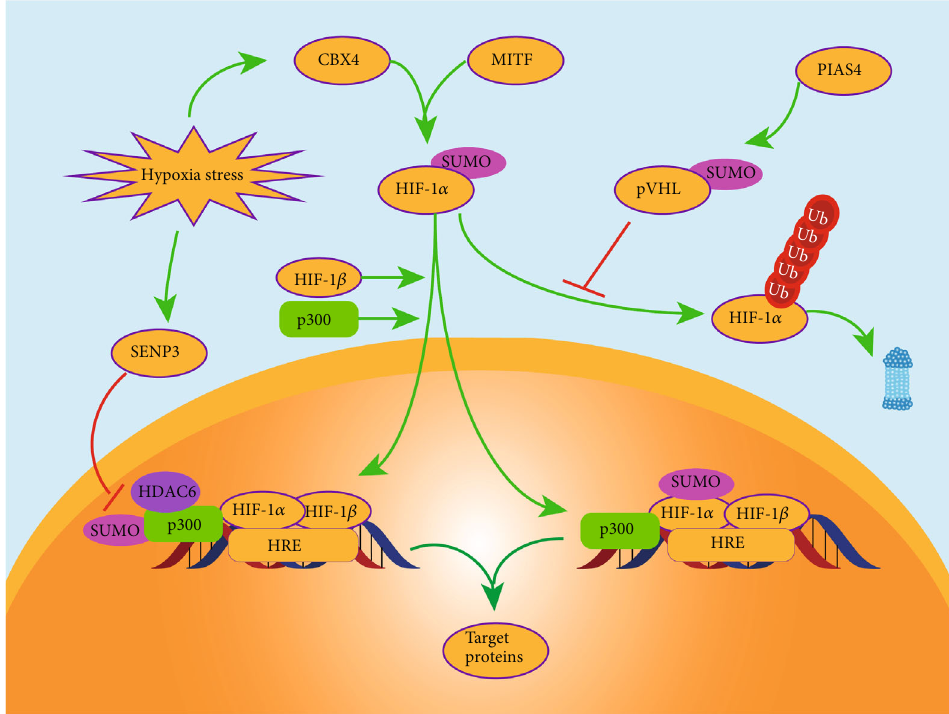
Figure 2: SUMOylation in the hypoxia pathway. SUMOylation plays a positive role in maintaining the stabilization of hypoxia-inducible factor 1-alpha (HIF-1 α ). SUMO-modi fi ed von Hippel – Lindau tumor suppressor (pVHL) cannot modify HIF-1 α by ubiquitination and degrade it through proteasomes. Microphthalmia-associated transcription factor (MITF) and chromobox 4 can upregulate HIF-1 α and facilitate its nuclear translocation. p300 can be modi fi ed by SUMOylation under mildly hypoxic conditions. SUMO-modi fi ed p300 can recruit HDAC6 and inhibits the transcriptional activity. This process can be inhibited by SENP3 through deSUMOylating p300 and thus increases the HIF-1-dependent vascular endothelial growth factor (VEGF)